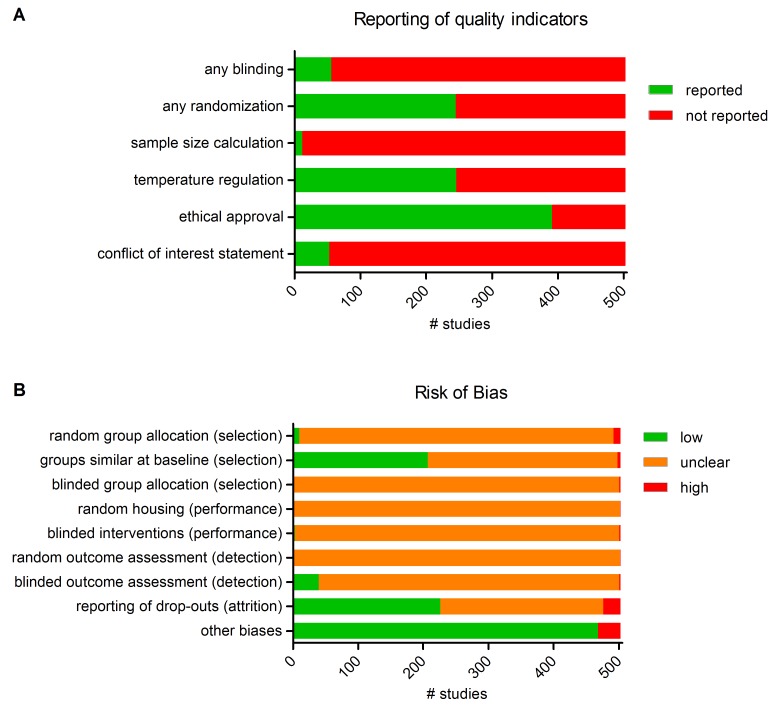
Reporting of study quality indicators and risk of bias in 503 included studies.
A, Reporting of three key study quality indicators was found to be poor in many cases. B, Using SYRCLE's risk of bias tool, the risks of selection, performance, detection, attrition and other biases were assessed. Lack of (adequate) reporting of measures to reduce bias resulted in a high percentage of unclear risk of bias for most items.